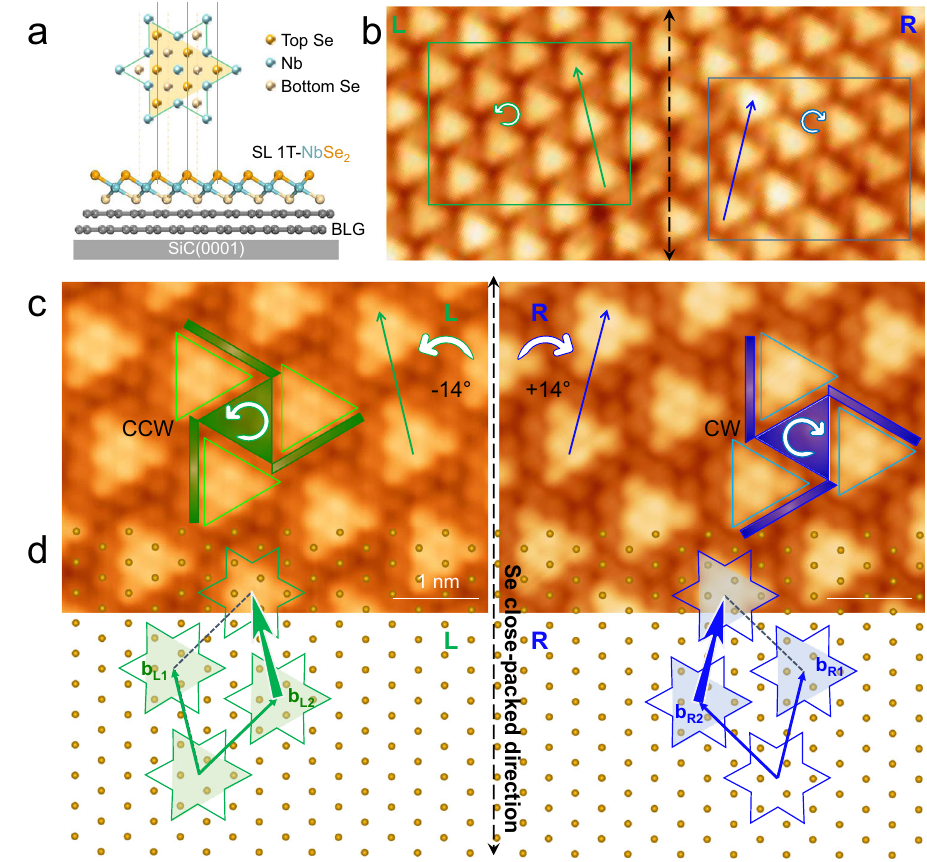
Fig. 1 STM topography and schematic model of chiral CDW superlattice. a (upper panel) Top view of SOD model showing thirteen Nb atoms, six top Se atoms, and six bottom Se atoms, with three-fold symmetry; (lower panel) side view of SL 1T-NbSe 2 on a BLG/SiC(0001) substrate. The top- and bottom- layer Se atoms are projected from the upper to the lower panel to show the relative positions. b CDW-resolved STM topography around a domain boundary of SL 1T-NbSe 2 . The top-Se close-packed direction is marked by the black dashed-arrow. c Left (right): Zoomed-in atomic-resolved image in the L (R) domain marked by the green (blue) frame in ( b ). The SOD superlattices in these two domains are labeled by green and blue triangles, respectively. The SODs arrangements are represented by the clockwise (CW) and counterclockwise (CCW) arrows. d Atomic model of SL 1T-NbSe 2 with chiral CDW domains. The atomic lattice of the top layer Se is indicated by the lattice of orange balls, and the SOD clusters in these two domains are labeled by green and blue triangles encircled by hexagram stars, respectively. Green and blue arrows crossing the adjacent SOD triangles represent the chiral CDW close- packed directions, which are rotated by ±14° with respect to the top-layer Se atom close-packed direction ( b L1 and b L2 for the L domain, and b R1 and b R2 for the R domain). Scanning parameters: b , bias voltage V B = − 1.5 V, tunneling current I t = 1 nA; c , V B = − 1.5 V, I t = 2